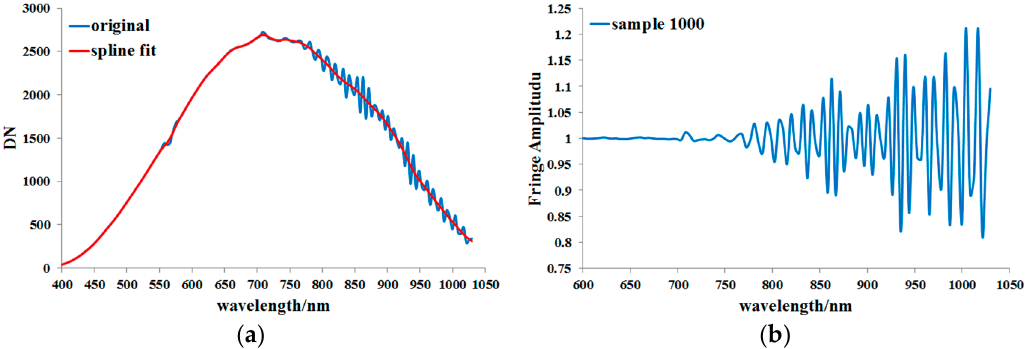
Figure 3. ( a ) DN response curves along sample 1000 and its spline fit result; ( b ) fringe amplitude along sample 1000.